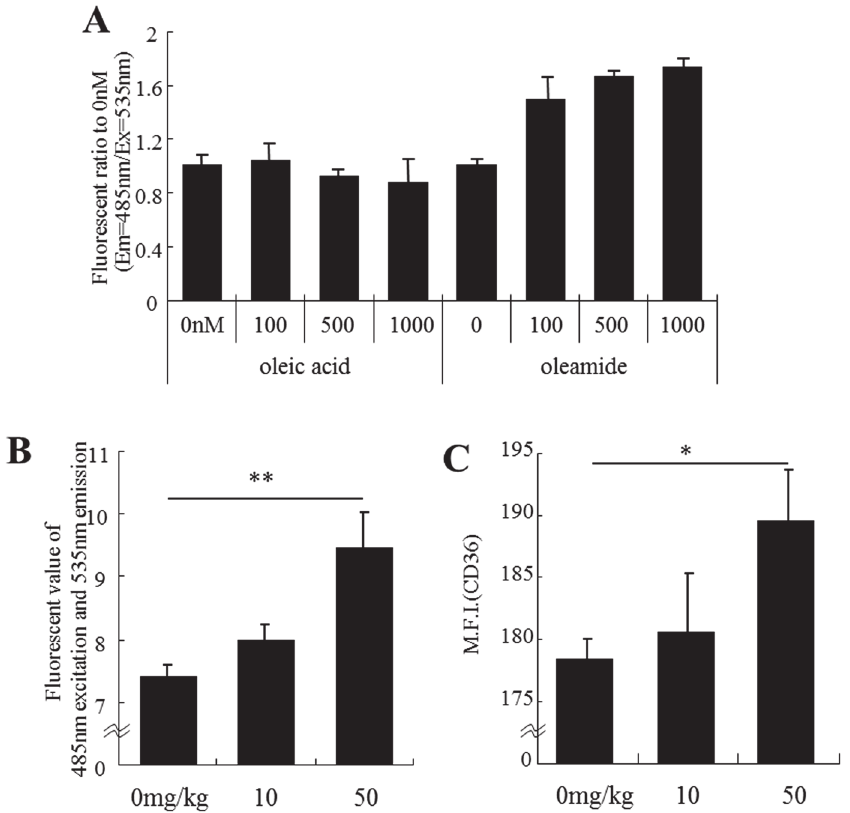
Fig 6. Effect of treatment with oleamide on microglial phagocytosis. A , A β phagocytotic activity was measured in vitro using isolated microglia pretreated with either oleic acid or oleamide. The value is the ratio of fluorescence to the vehicle. Error bars represent the means ± SEM (n = the number of wells when we examined phagocytosis of A β 1 – 42) B and C , Effect of treatment with oleamide in vivo on microglial phagocytotic activity. After the oral administration of 0, 10, or 50 mg/kg of oleamide once a day for 3 days and isolation of microglia from the brain, phagocytotic activity and the expression of CD36 were measured. B , Cellular A β -FAM was measured after isolated microglia were treated with 500 nM A β -FAM for 5 hours and quenched extracellular A β -FAM. C , Expression of CD36 in CD11b single-positive cells. Error bars represent the means ± SEM of 5 mice per group. * p < 0.05 and ** p <